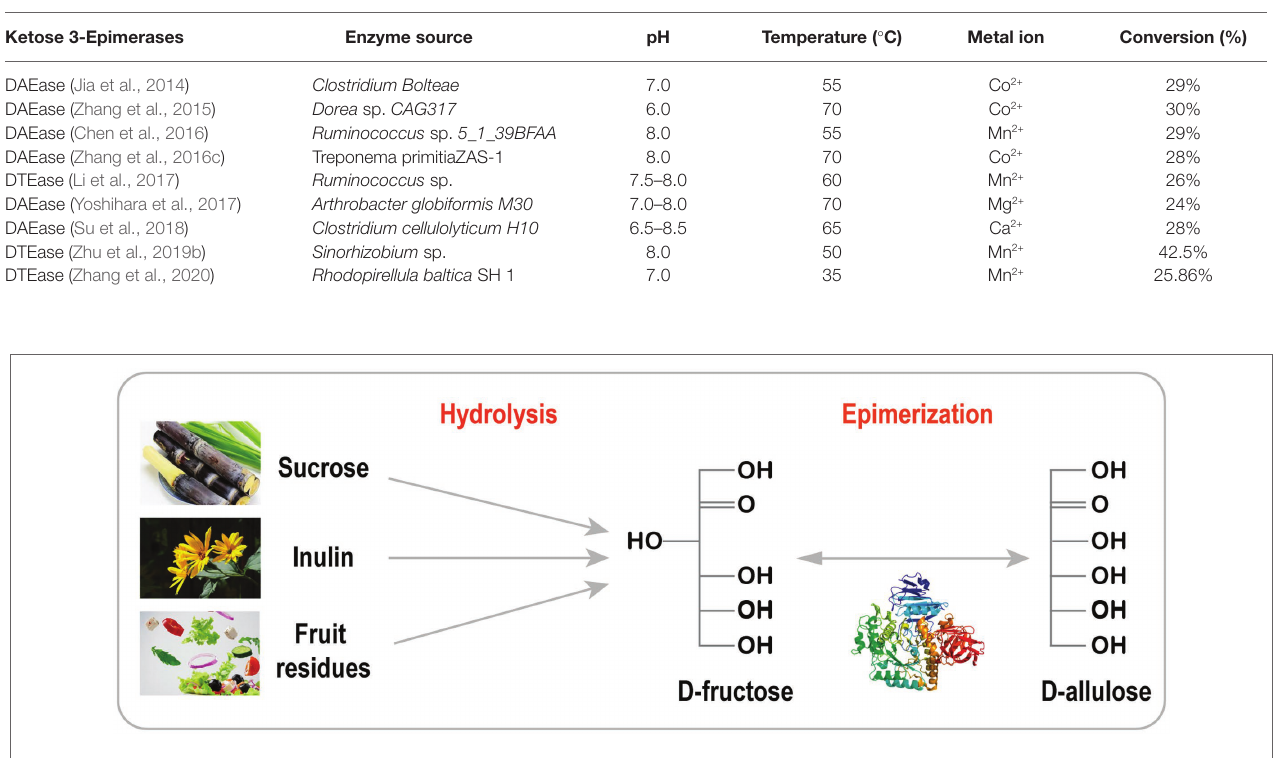
FIGURE 3 | Biosynthesis of D-allulose from inexpensive raw